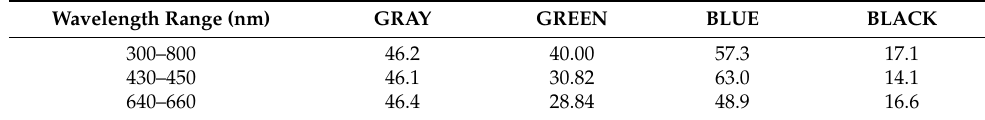
Table 2. Light transmittance of the colored shade net (gray, green, blue, or black) at different wave- lengths. This was calculated by dividing the sum of the values of the shading treatment transmission spectra in the 430–450 nm range by the sum of the values of the solar spectrum in the same range. Wavelength Range (nm)